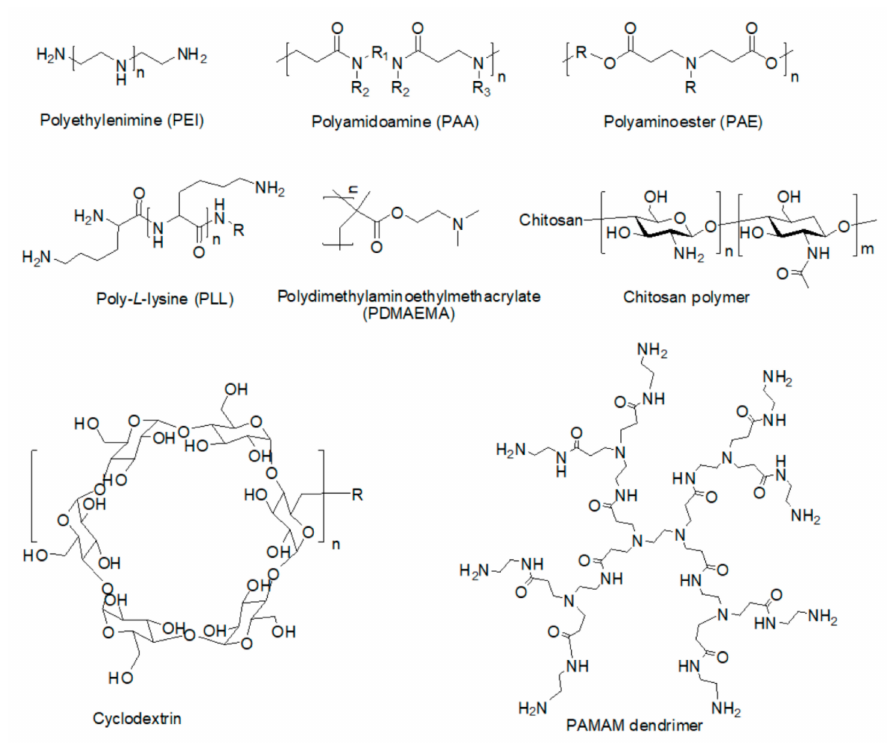
Figure 4. The structures of